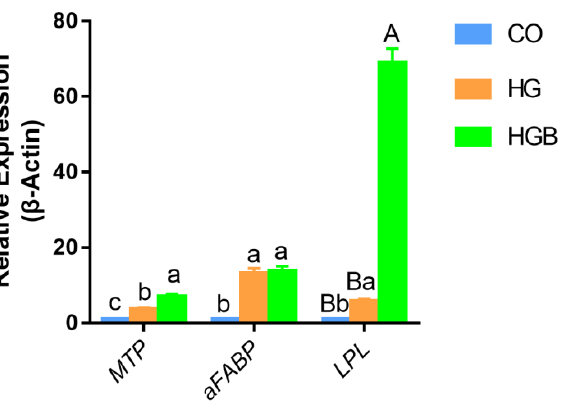
Figure 8. The relative mRNA expression levels of key genes ( MTP , aFABP , and LPL ) in fatty acids transportation and decomposition pathway with different treatments. Different lowercase letters indicate a significant difference ( p < 0.05), and the different capitals indicate an extreme difference ( p < 0.01). CO: control group (0 mmol/L of glucose + 0 mmol/L of betaine); HG: 20 mmol/L of glucose + 0 mmol/L of betaine group; HGB: 20 mmol/L of glucose + 20 mmol/L of betaine combined treatment group.